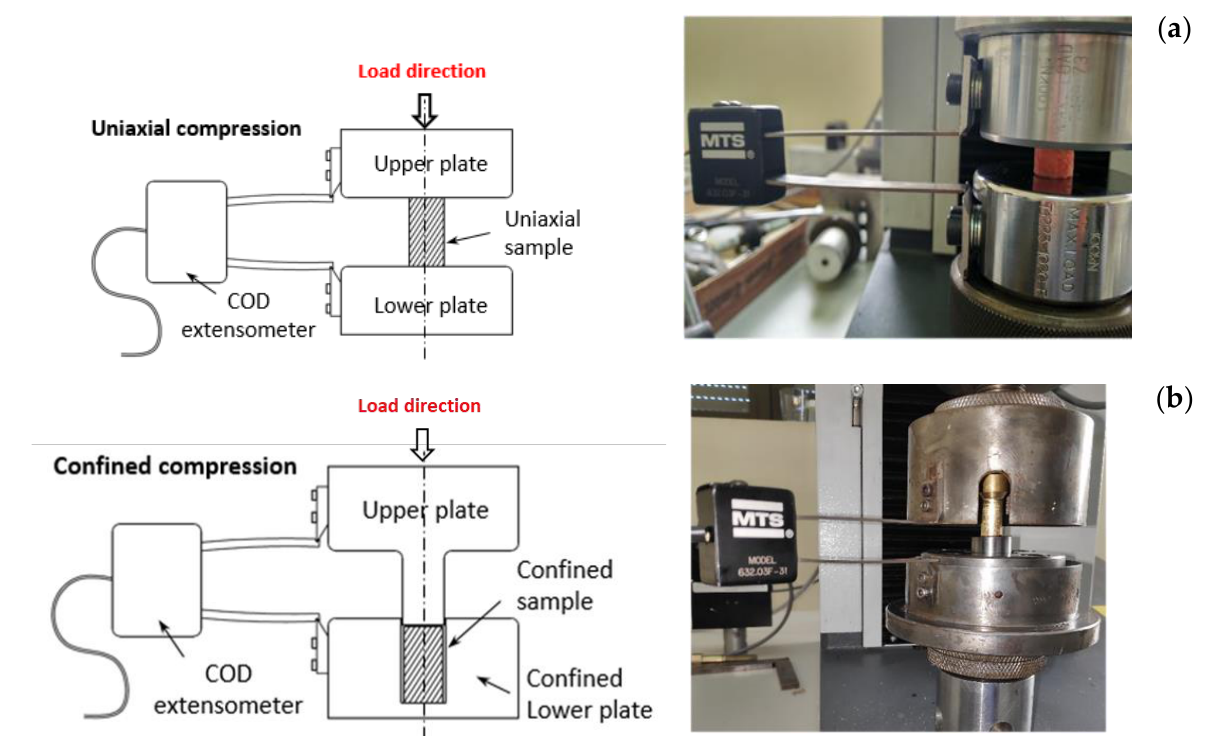
Figure 4. Uniaxial ( a ) and confined ( b ) compression tests configuration.